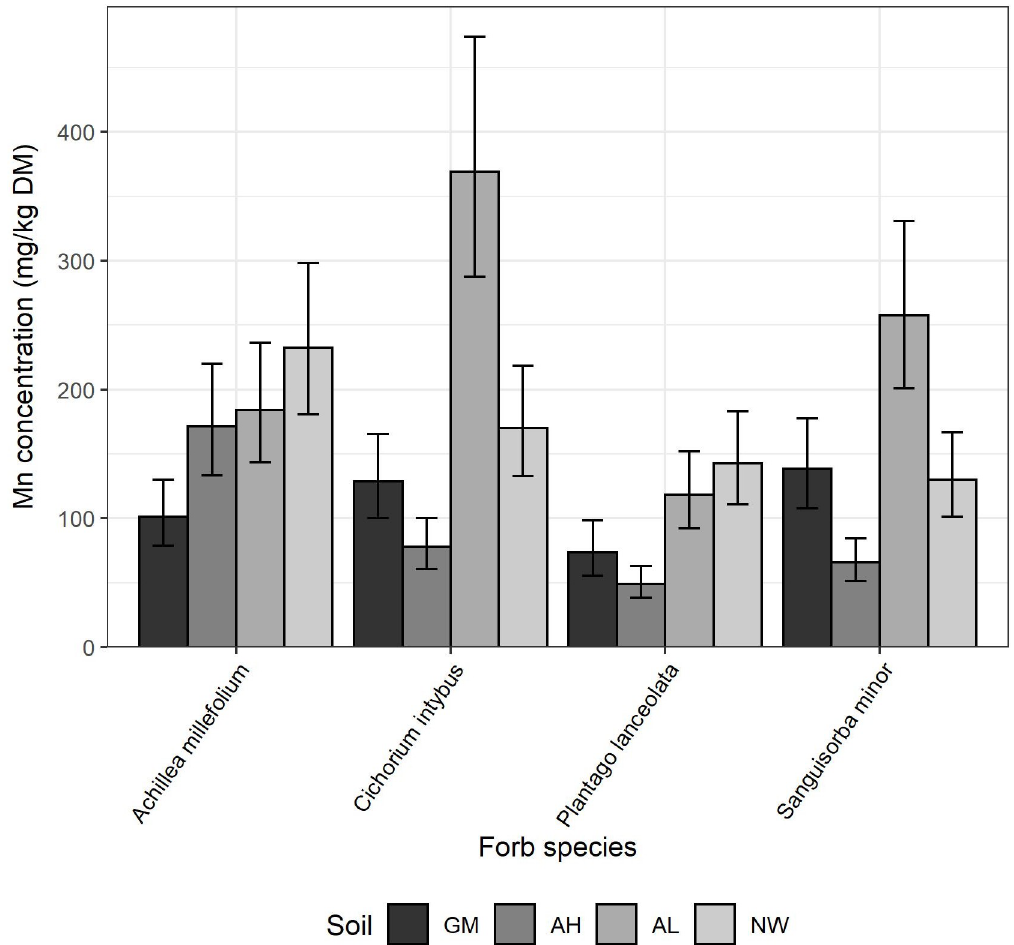
Fig 4. Mean Mn concentration in the plant material of each of the four forb species tested when grown on the Growing Medium (GM), Arable High pH (AH), Arable Low pH (AL) and North Wyke (NW) soils. Error bars are the confidence interval of the back-transformed mean. Average least significant difference (LSD) across all treatments on the back- transformed scale was